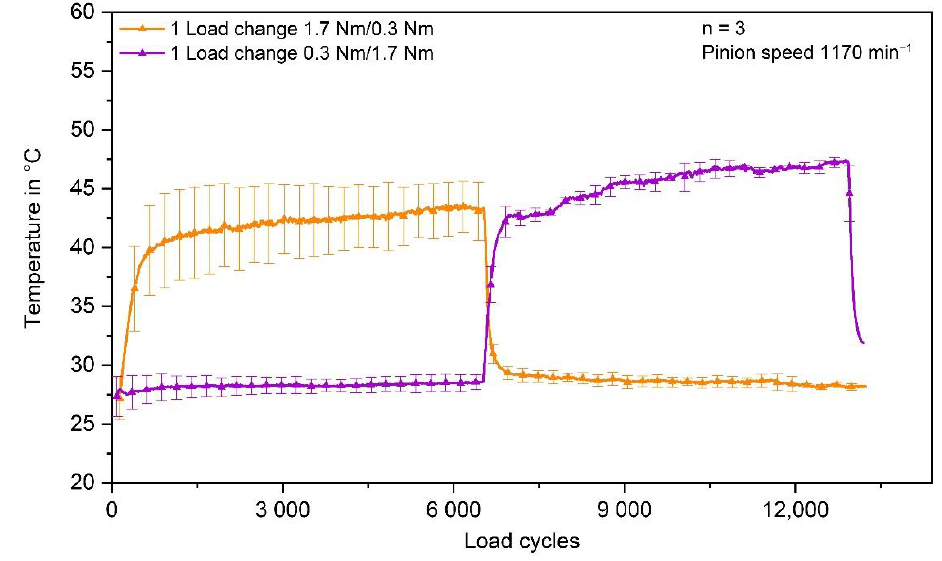
Figure 10. Temperature of the gears tested with one load change in different sequence.